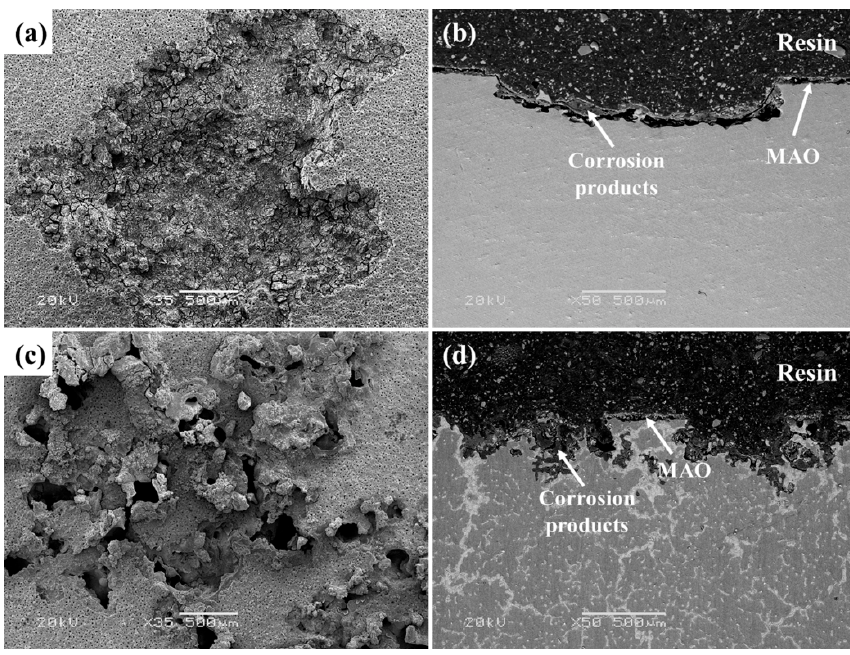
Figure 11. Surface and cross-section micrographs of the MAO-treated AZ31 ( a , b ) and AZ91 ( c , d ) alloys after 420 h immersion in 0.1 M NaCl solution.